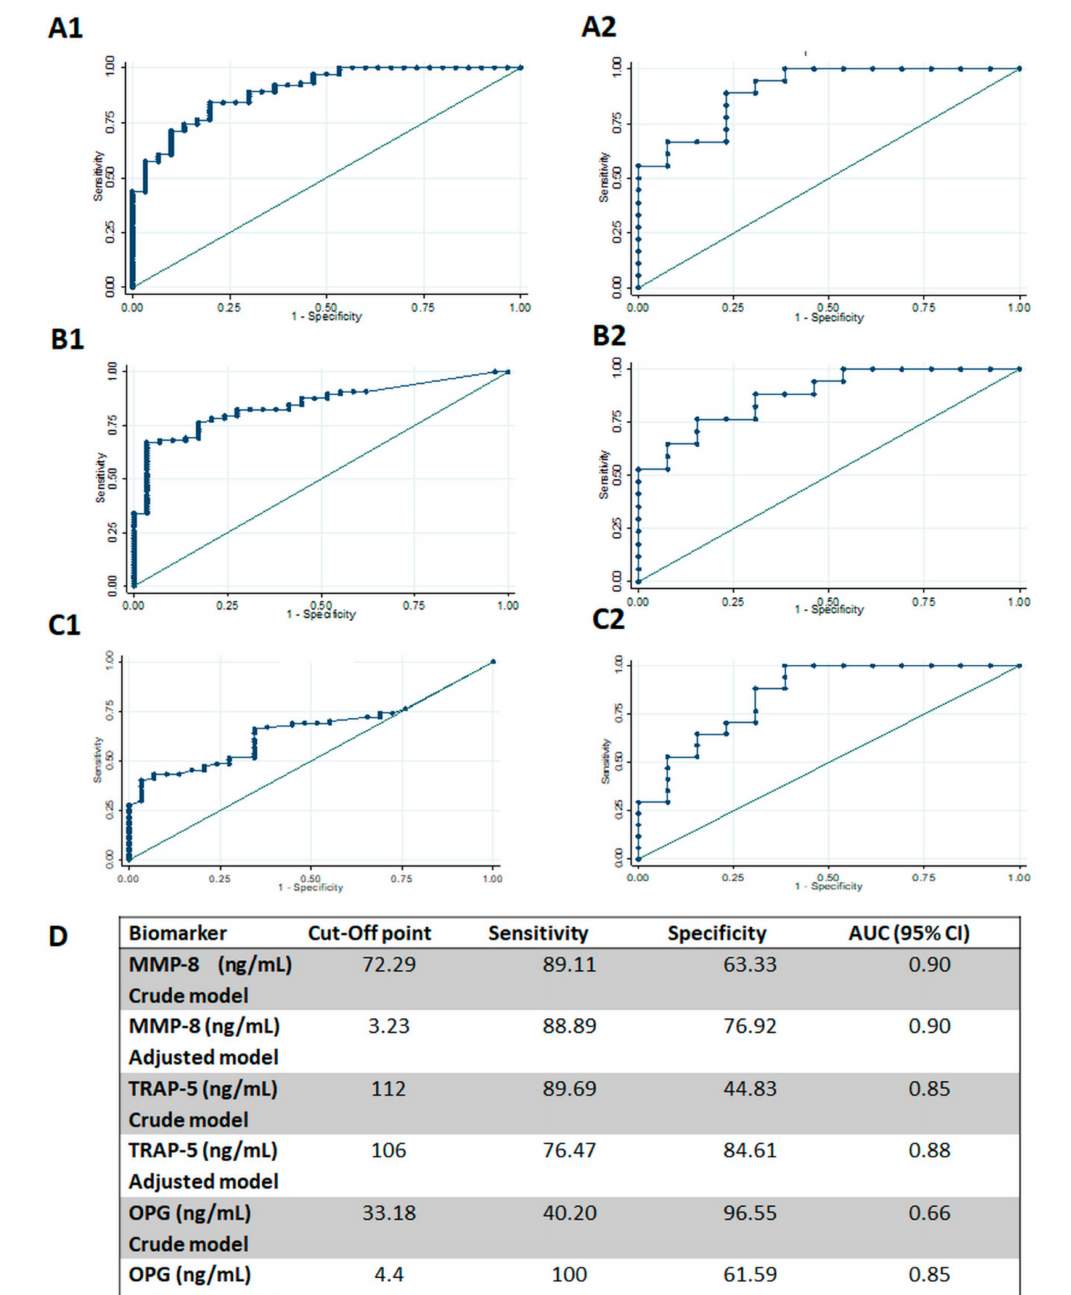
Figure 1. Diagnostic potential of biomarkers to identify healthy sites. ( A ). Crude ( A1 ) and adjusted models ( A2 ); ( B ). diagnostic potential of TRAP5 to identify healthy from periodontitis sites, crude ( B1 ) and adjusted ( B2 ); ( C ). diagnostic potential of OPG to identify healthy from periodontitis sites, crude ( C1 ) and adjusted ( C2 ); ( D ). sensitivity, specificity, and cut-o ff points of MMp-8, TRAP5, and OPG in their diagnostic potential to identify healthy from periodontitis sites. AUC: area under de curve. CI: confidence interval. MMP-8: matrix metalloproteinase-8, TRAP5: tartrate-resistant acid phosphatase-5, and OPG: